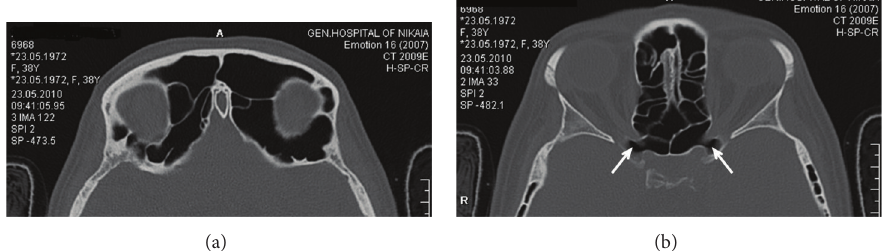
Figure 3: (a) The frontal sinus enchroaching the orbit. (b) The optic nerves are exposed (arrows) in the superior part of the sphenoid sinus.